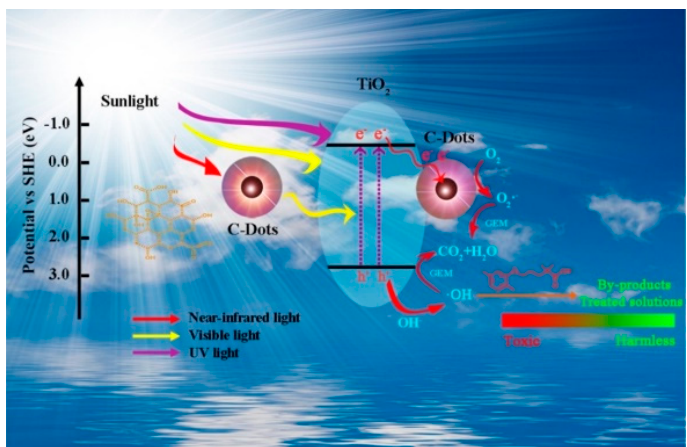
Figure 4. The schematic photocatalytic mechanism of Gembrozil (GEM) degradation by the CDs / TiO 2 composite under simulated sunlight irradiation. C-Dots: carbon dots. SHE: standard hydrogen electrode. Figure adapted from reference [95].